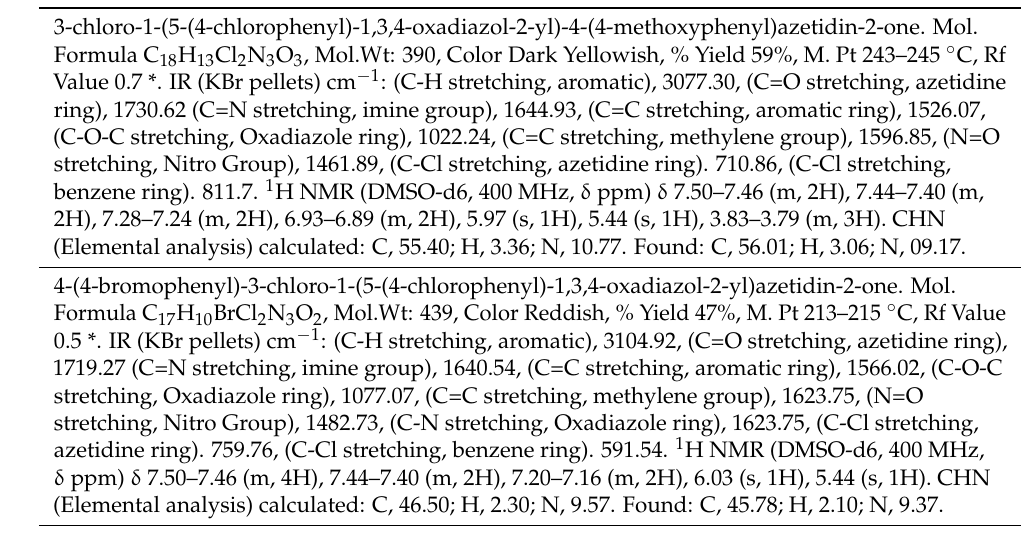
Table 5. Spectroscopic properties of synthesized